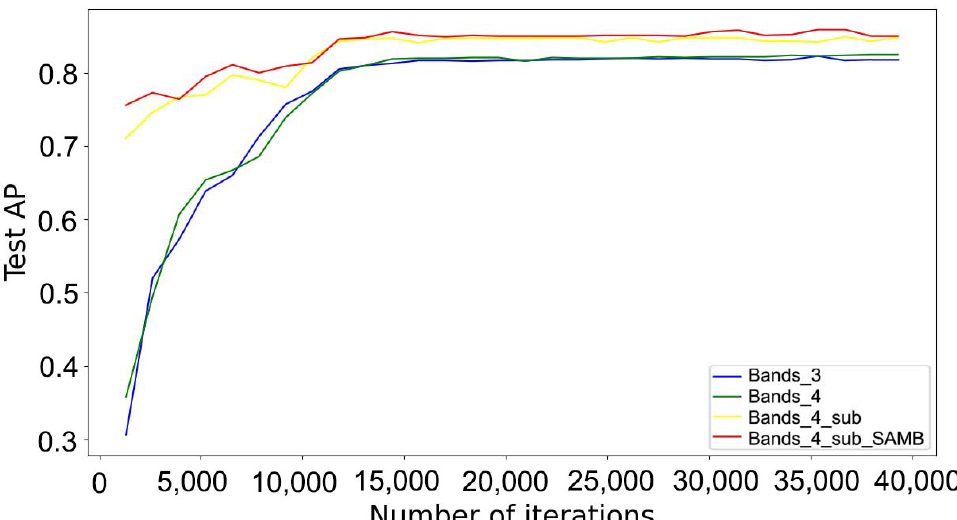
Figure 8. Test precision curves for different models. Table 3. Test results for different